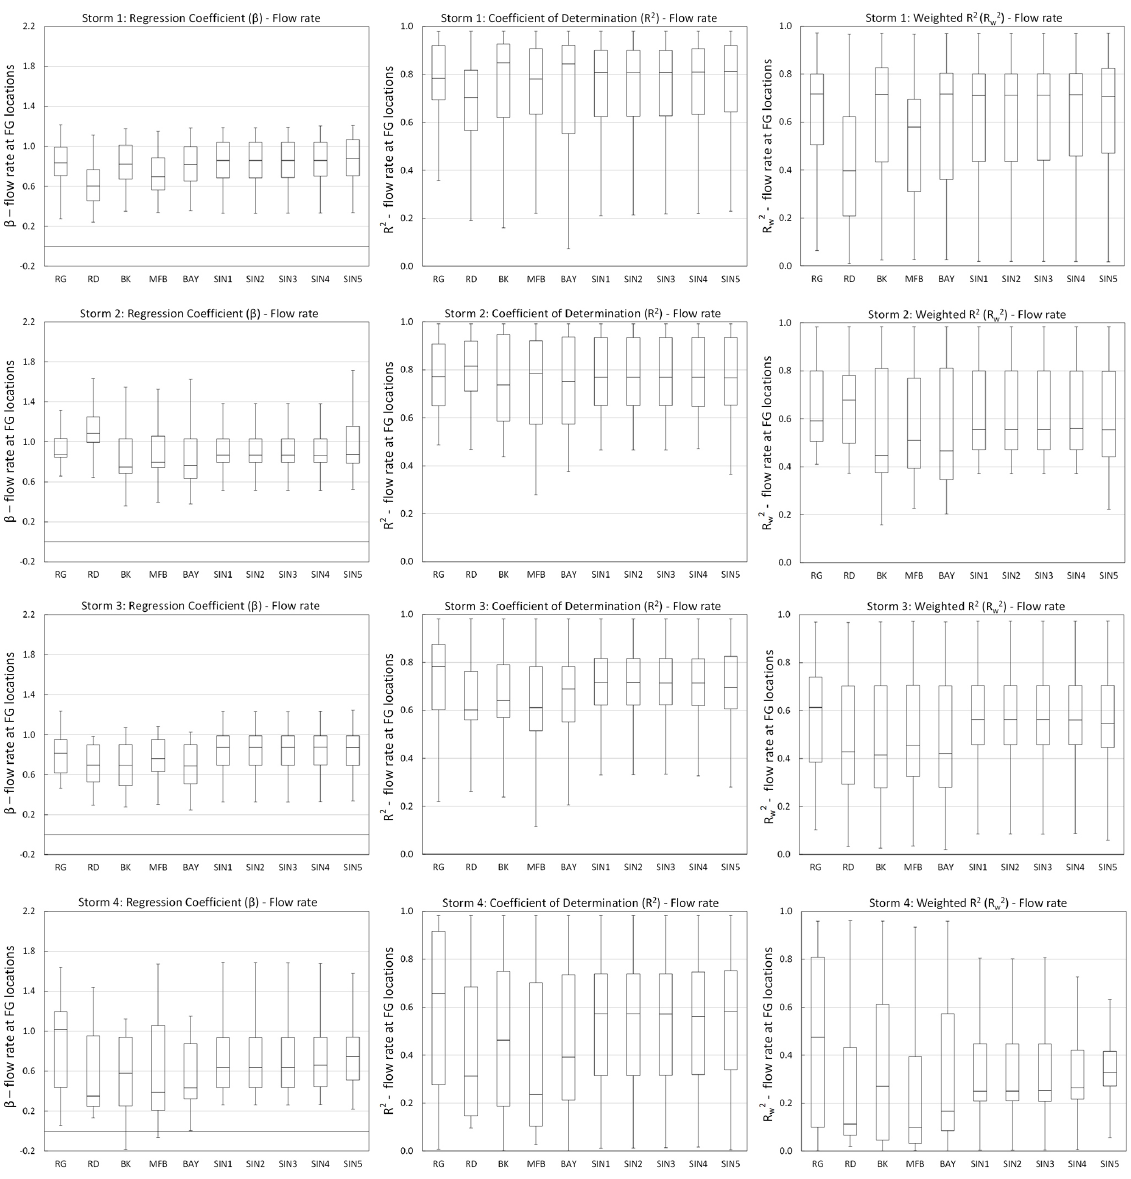
Figure 10. Boxplots displaying the distribution of regression coefficient ( β ) (left column panels), coefficient of determination ( R 2 ) (middle column panels) and weighted coefficient of determination ( R 2 w ) (right column panels) statistics derived from the linear regression analysis conducted for each pair of recorded and simulated flow time series at each gauging